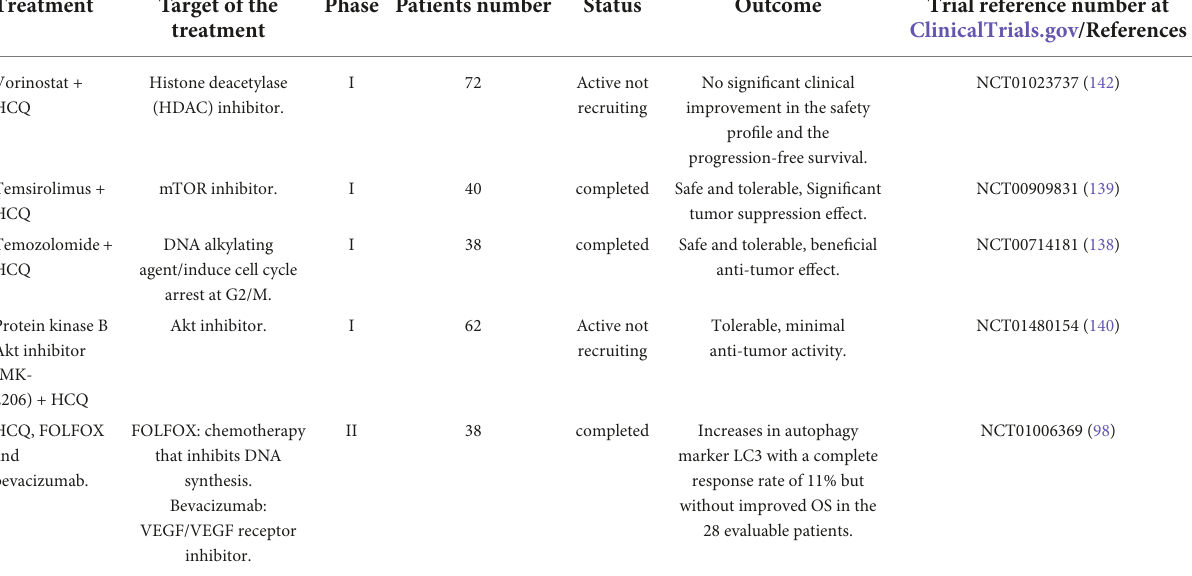
TABLE 2 Previous and current clinical trials involving hydroxychloroquine (HCQ) in combination with a variety of anti-cancer targeted agents in CRC. Treatment Target of the Phase Patients number Status Outcome treatment Vorinostat +